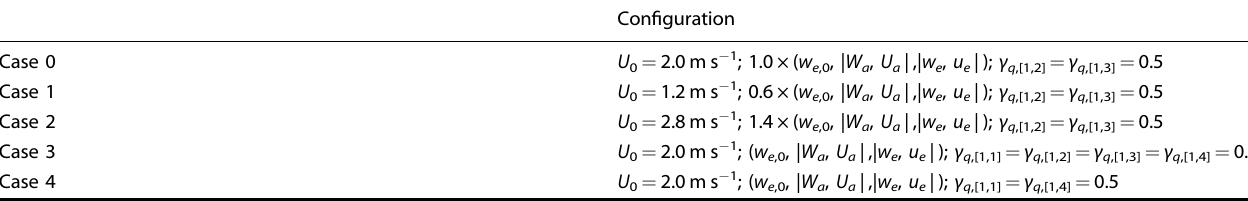
Table 2. Summary of the multi-box model simulations for reactive species (a) .